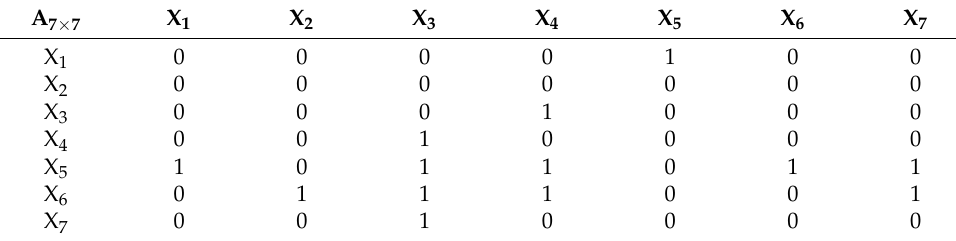
Table 5. The adjacency matrix A.